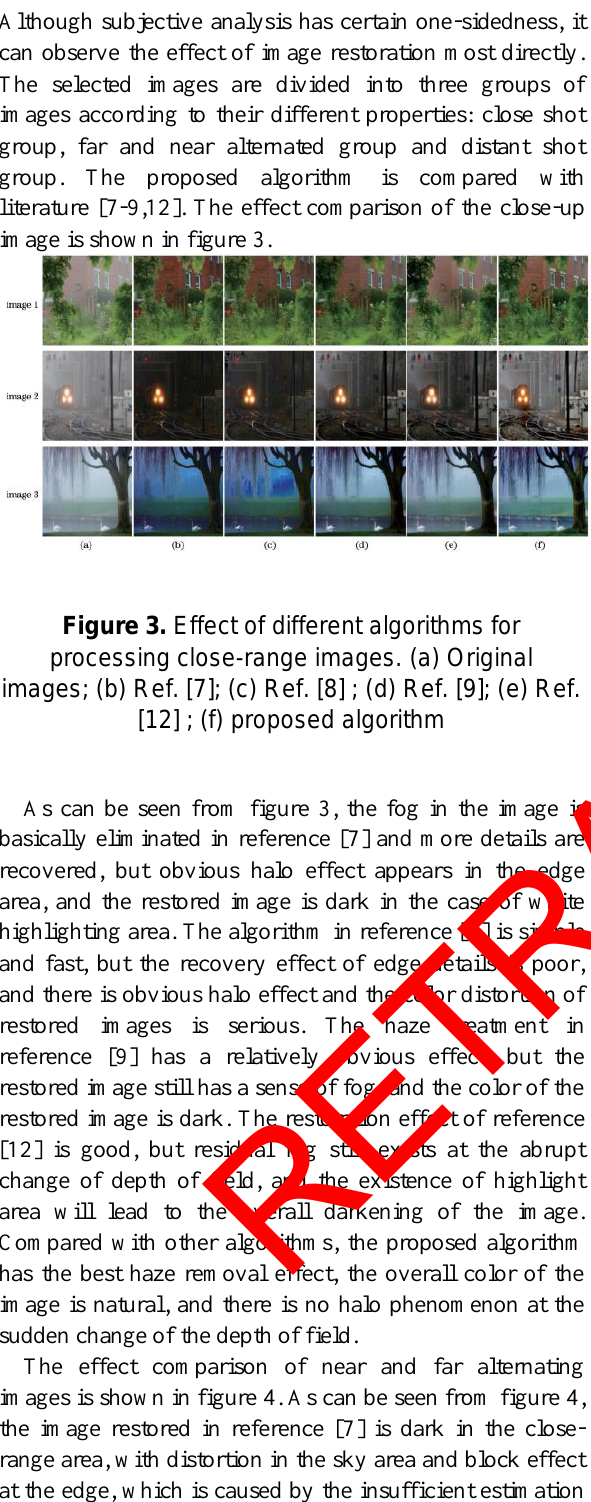
Figure 5. Effect of different algorithms for processing perspective images. (a) Original images; (b) Ref. [7];(c) Ref. [8] ; (d) Ref. [9]; (e) Ref. [12] ; (f) proposed